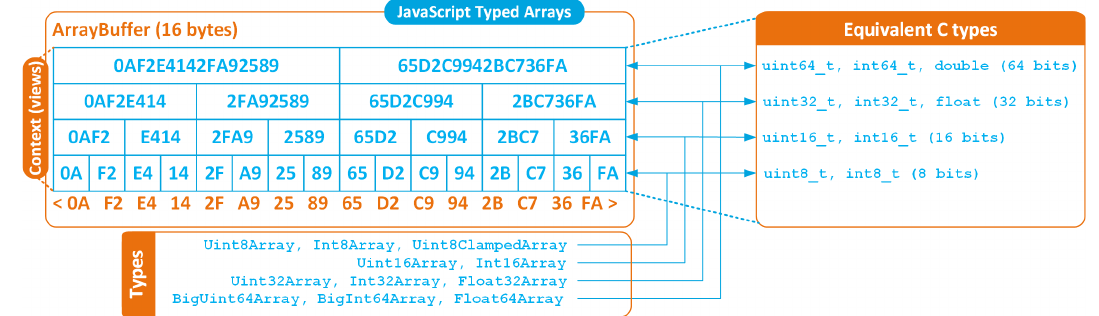
Figure 5. JavaScript Typed Arrays: physical data structure, context and equivalence with C